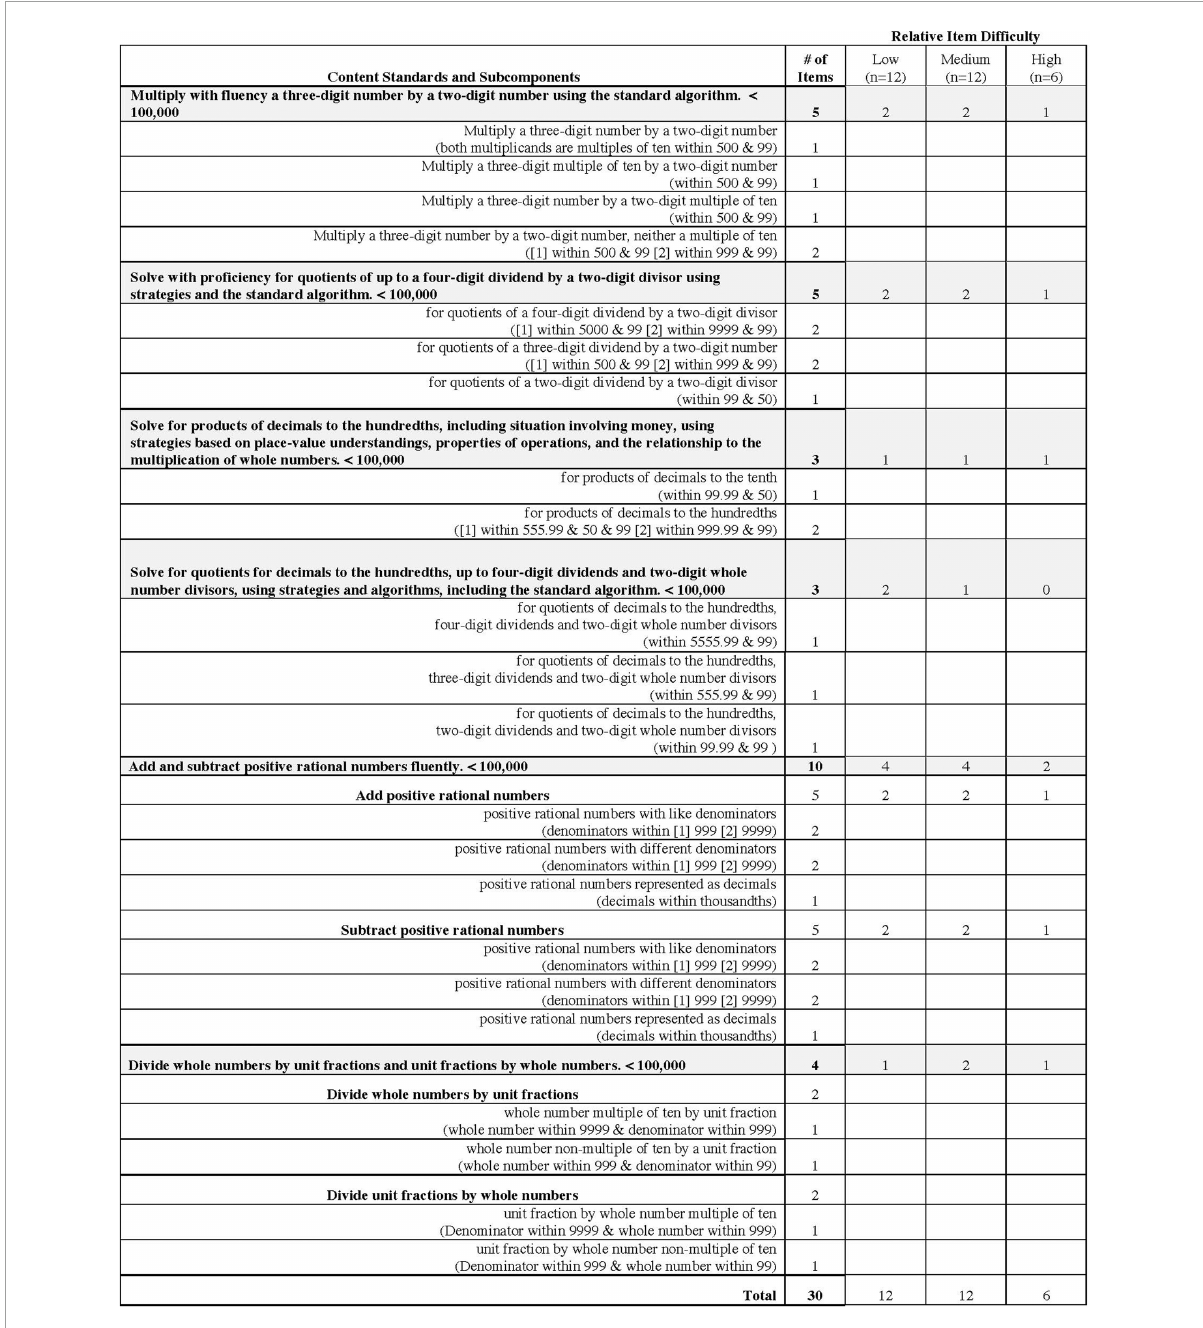
FIGURE4 Content matrix for Grade